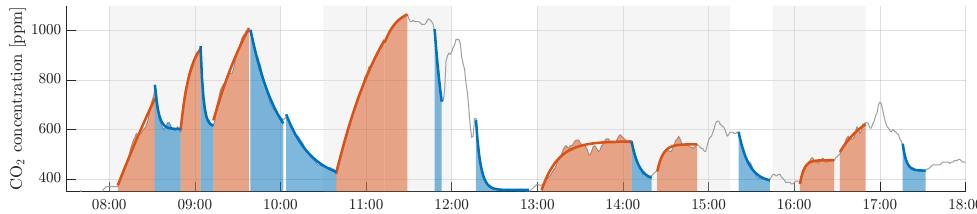
Figure 4. Example of the sectioning into adjustment windows for a particular day. The grey curve corresponds to the CO 2 concentrations at the front of the classroom with monitor AQ1. Orange and blue areas identify adjustment windows with build-up and decay of CO 2 , respectively. Orange and blue curves depict the adjusted box model for each window. The grey shaded background identifies occupation periods for the